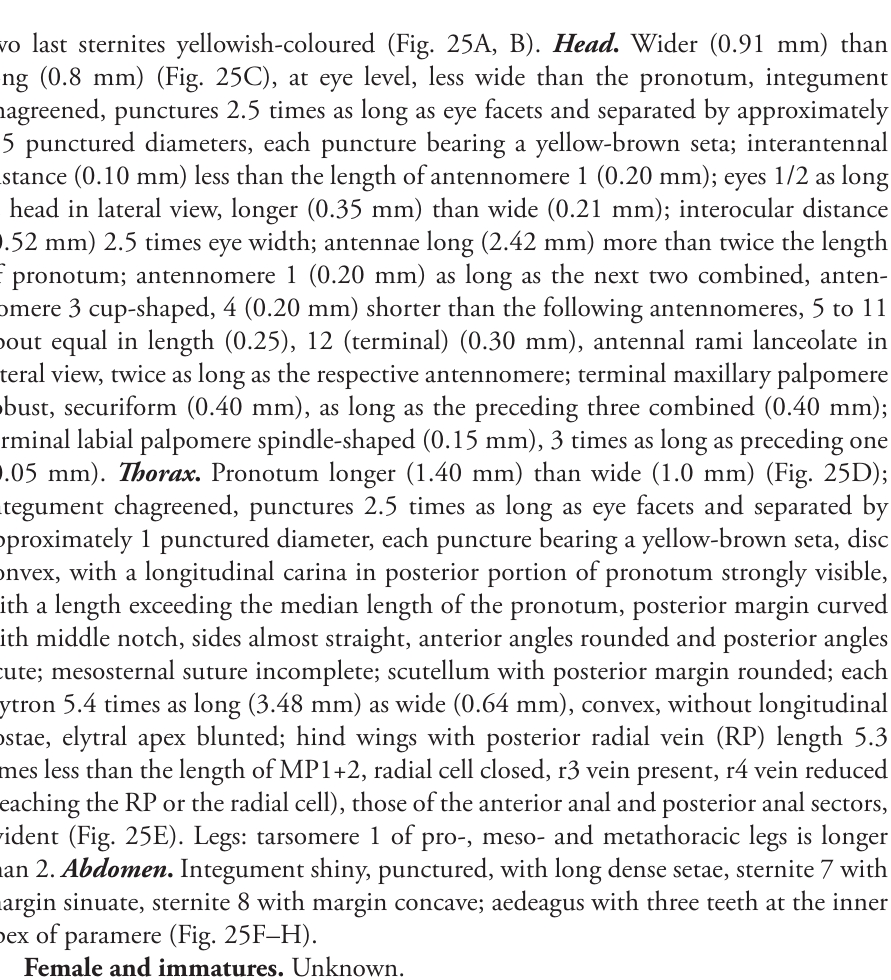
Fig. 26A–H Type locality.